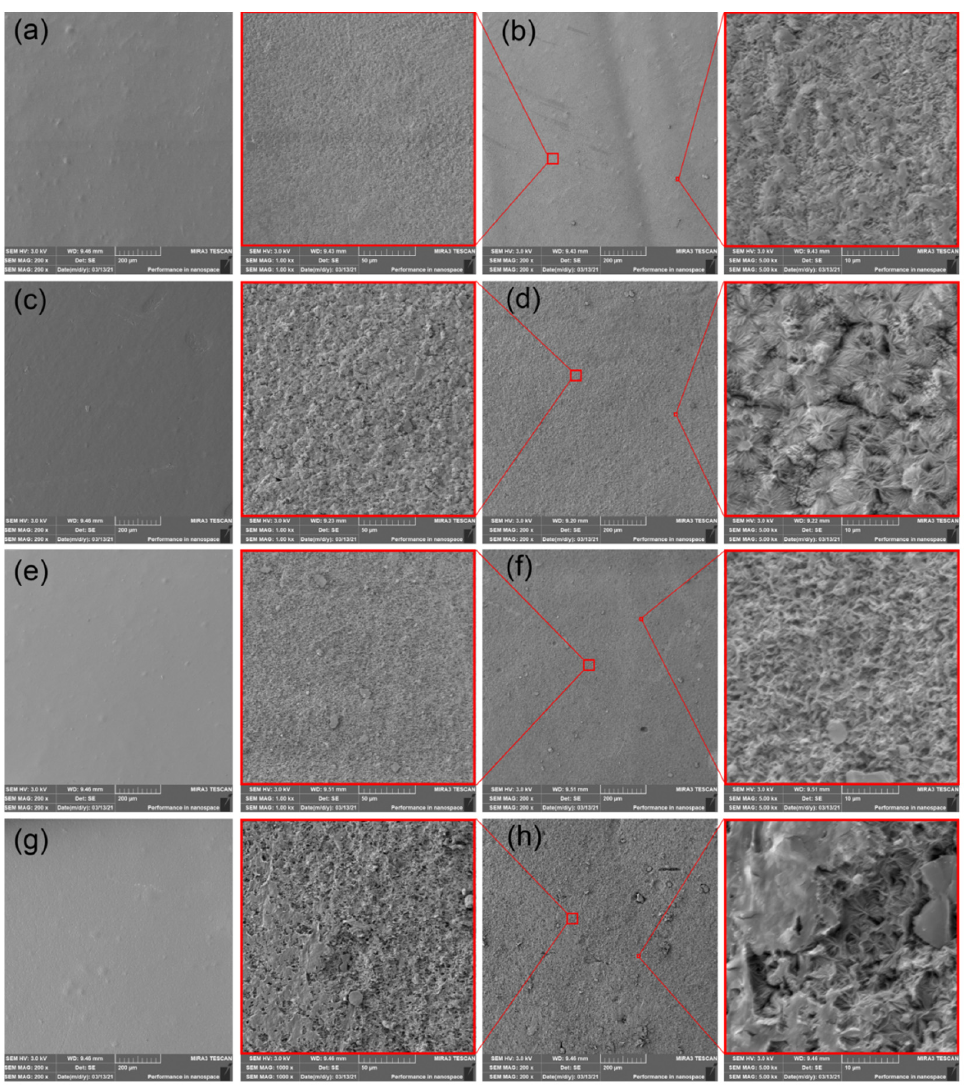
Figure 5. SEM images of ( a ) neat PHBV film at initial state, ( b ) neat PHBV film after 30 days of degradation in vermicompost environment, ( c ) PHBV/ATBC at initial state, ( d ) PHBV/ATBC film after 30 days of degradation in vermicompost environment, ( e ) PHBV/ATBC/L-CNC at initial state, ( f ) PHBV/ATBC/L-CNC film after 30 days of degradation in vermicompost environment, ( g ) PHBV/ATBC/CaCO 3 at initial state, ( h ) PHBV/ATBC/CaCO 3 film after 30 days of degradation in vermicompost environment.